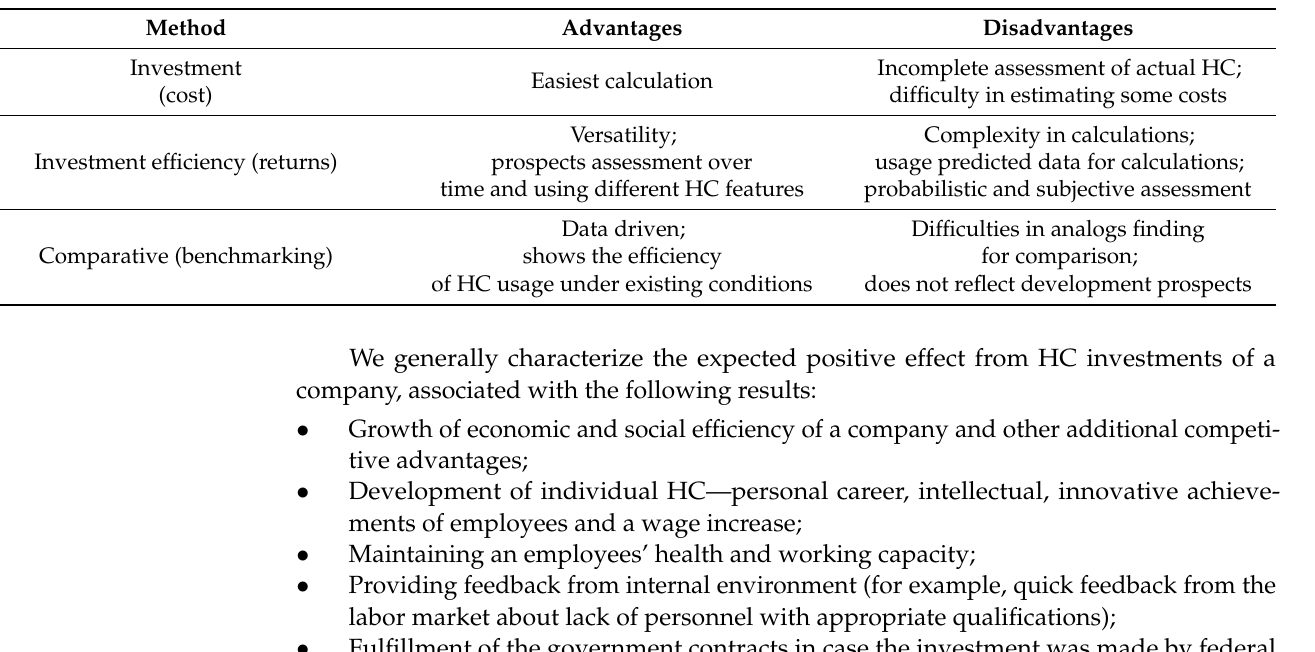
Table 1. Advantages and disadvantages of HC assessment